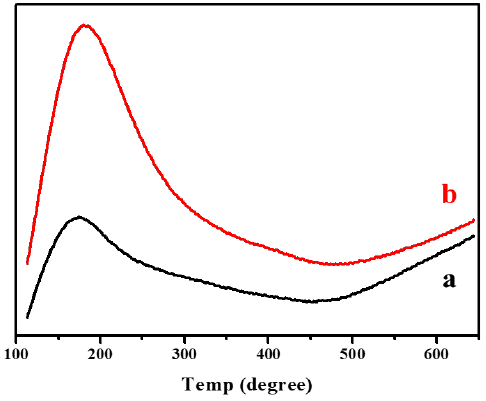
Figure 7. NH 3 -TPD curves of ( a ) RUB-37 and ( b ) Sn-JHP-2.